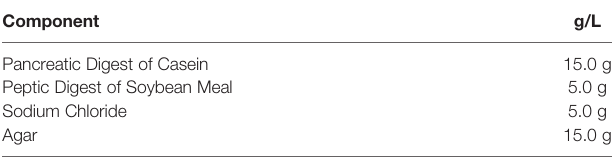
TABLE 10 | RPMI 1640 Thermo. TABLE 11 | Tryptic soy agar Criterion ™ .